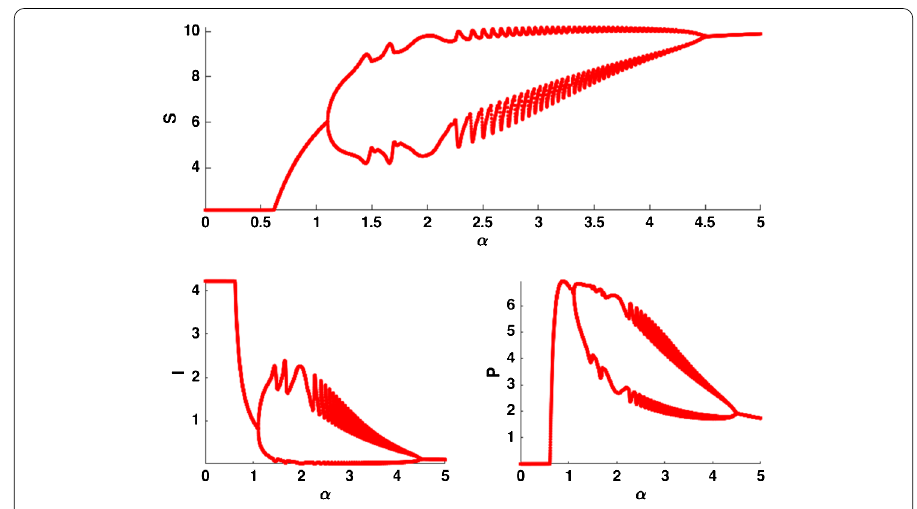
Figure 9 Bifurcation diagram of the fractional-order model (3) with respect to predator’s attack rate ( α ) when q = 0.9